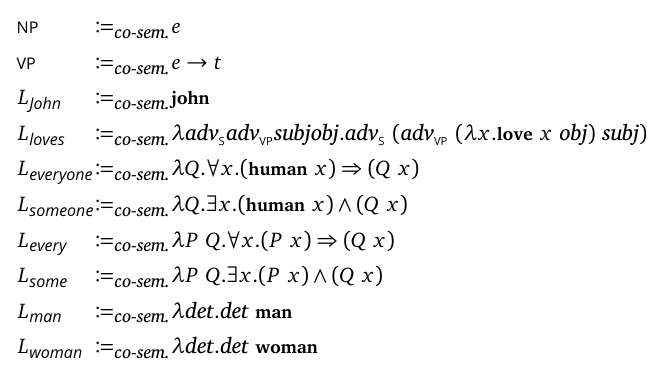
Table 24: Constants of (cid:6) CoTAG and their interpretation by G co-sem.